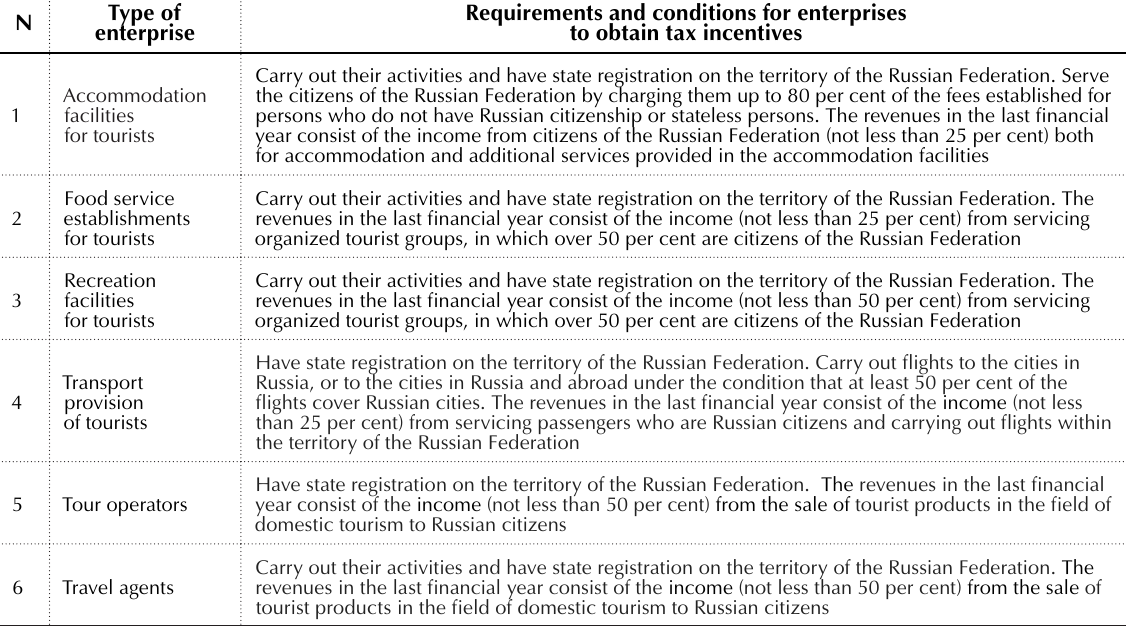
Table 3. Classification of domestic tourism